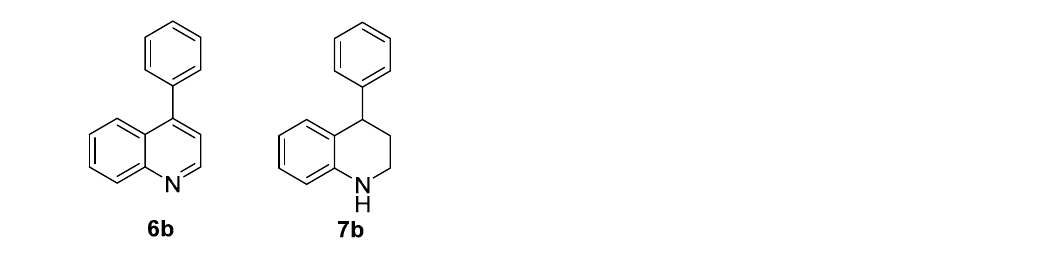
Figure 2. Structure of the 4-phenylquinoline 6b and 4-phenyl-1,2,3,4-tetrahydroquinoline 7b obtained from compound 4b in the condition reported in Scheme 2.